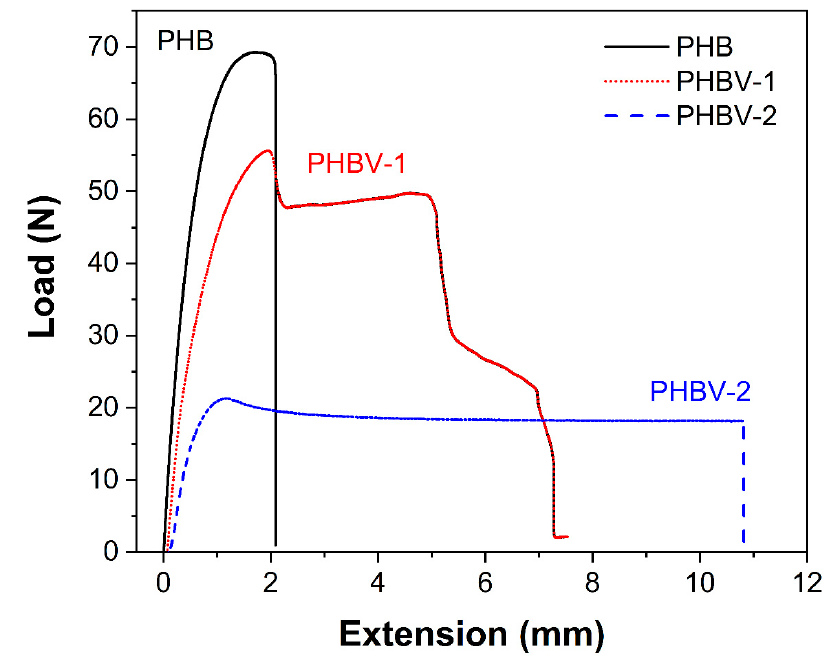
Figure 5. Load versus extension curves for the PHB, PHBV-1, and PHBV-2 scaffolds. Table 3. Crystallinity index and mechanical behavior of the PHB, PHBV-1, and PHBV-2 scaffolds.